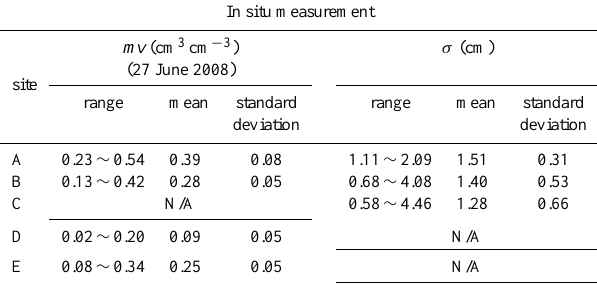
Table 1. Ground truth measurements of soil moisture and surface